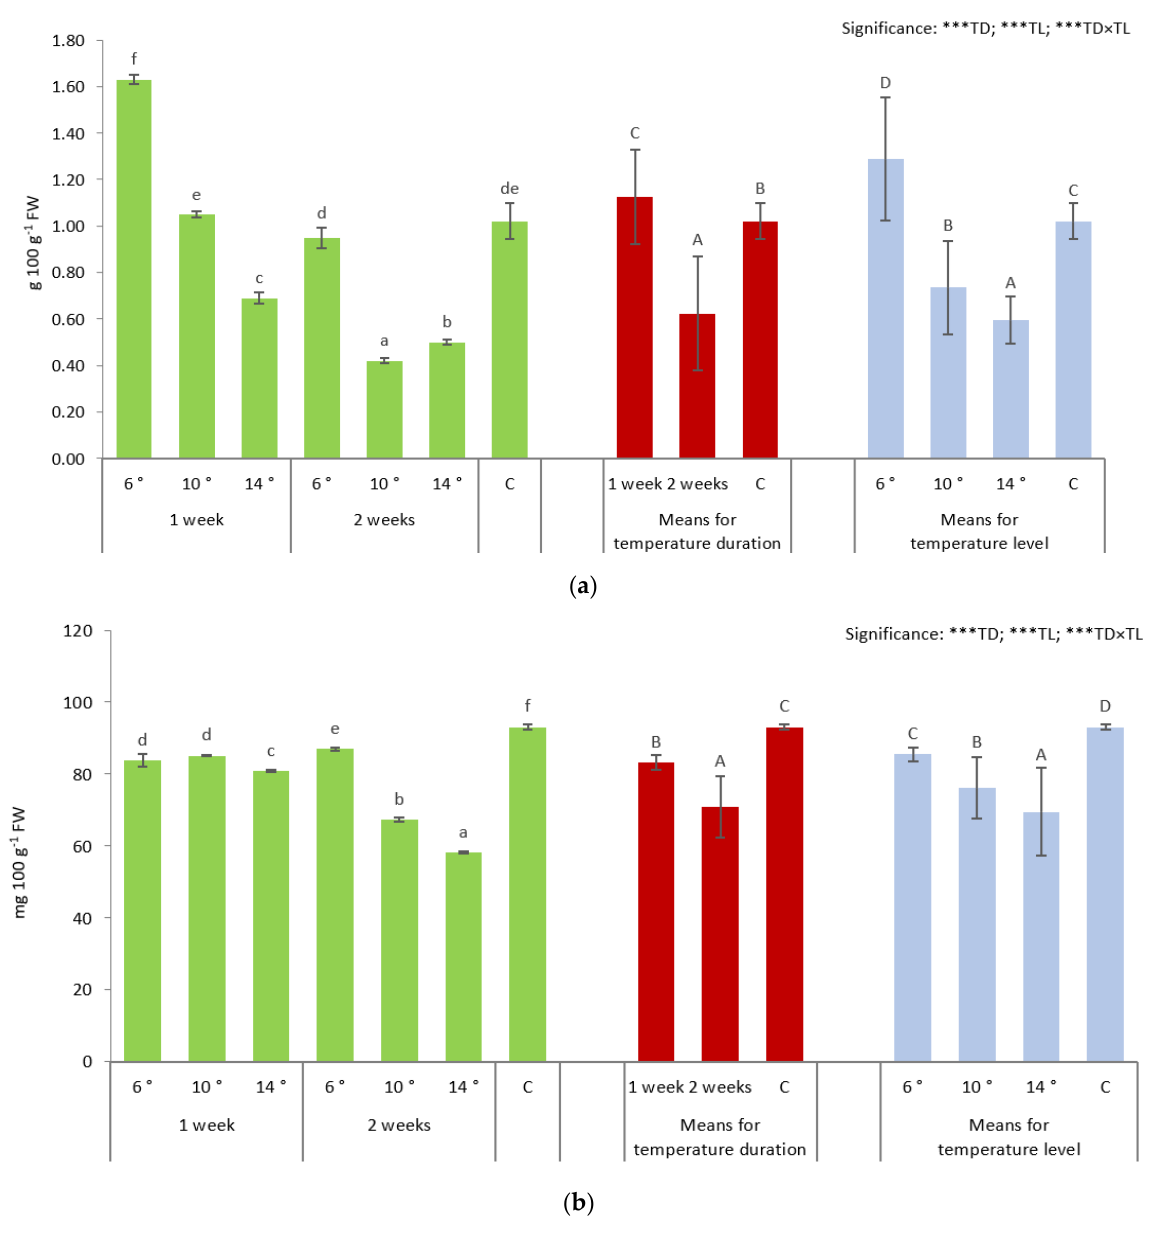
Figure 1. Content of soluble sugars ( a ) and L-ascorbic acid ( b ) of broccoli seedlings depending on the temperature duration (TD: 1 week and 2 weeks) and level (TL: 6 °C, 10 °C, 14 °C, 18 °C—control, C). Means followed by different capital letters with regard to temperature duration and temperature level effects (red and blue columns, respectively), and lowercase letters for interactions (TD × TL; green columns) are significantly different at p ≤ 0.05, according to Tukey’s honestly significant difference test. Level of significance: *** p ≤ 0.001. Data are means of four replications ± SD (error bars).